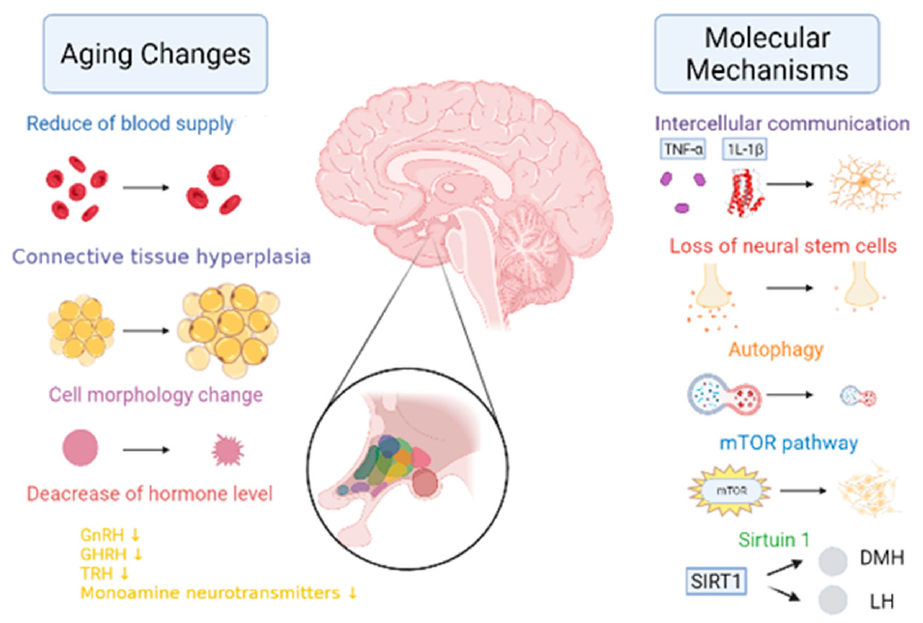
Figure 6. The changes and molecular mechanisms of hypothalamic aging. With aging, the hy- pothalamus undergoes the following changes in aging: a significant reduction in blood supply [16]; the proliferation of connective tissue [17]; a change in cell morphology [18]; a reduction in the gonadotropin-releasing hormone (GnRH) [20], the growth hormone releasing hormone (GHRH) [20], the thyrotropin-releasing hormone (TRH) [20], and in the monoamine neurotransmitter levels [23]. Molecular mechanisms of aging include the following: a blocked TNF- α and IL-1 β signaling; the loss of neural stem cells [24]; reduced autophagy [25]; enhanced mTOR activity [26]; and reduced SIRT1 expression in SCN, thereby resulting in reduced dorsal medial hypothalamic (DMH) and lateral hypothalamic (LH) activity [27,28].